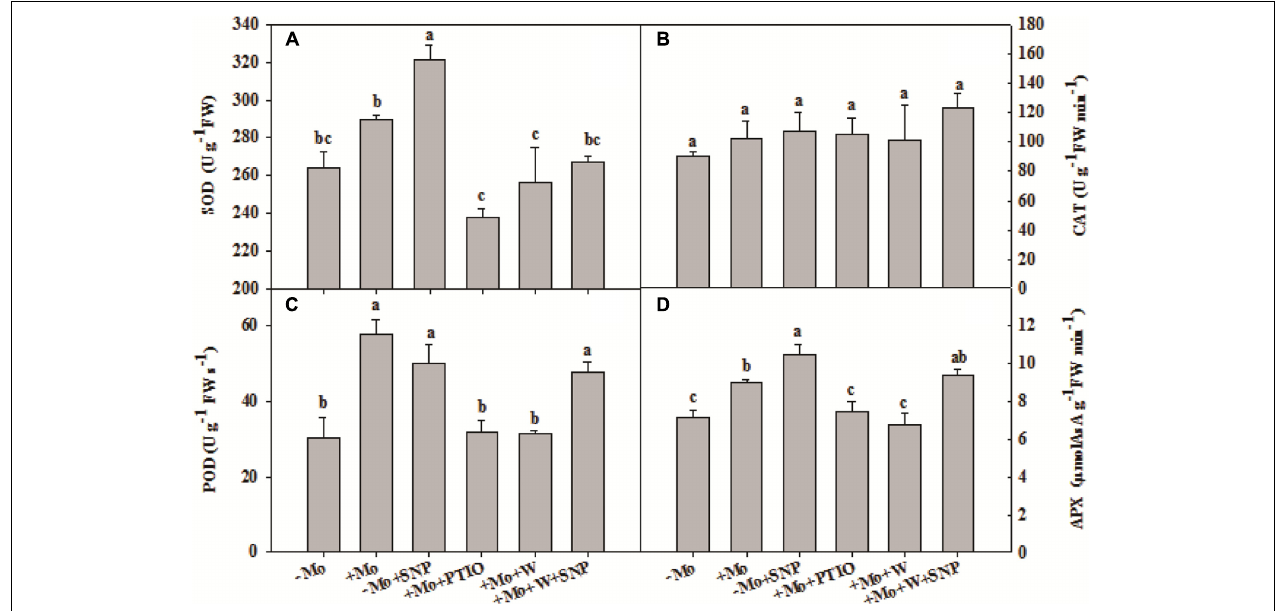
FIGURE 5 | Effects of molybdenum (Mo), 100 µ M tungsten (W, Mo-enzymes inhibitors), 200 µ M 2-phenyl-4,4,5,5-tetramethylimidazoline-3-oxide-1-oxyl (PTIO, NO scavenger), and 100 µ M sodium nitroprusside (SNP, NO donor) on activities of antioxidant enzymes in wheat leaves. The 30-day-old seedlings grown in –Mo and +Mo Hoagland solutions were detached and placed in distilled water for 2 h to eliminate potential wound stress and firstly pretreated with/without 200 µ M PTIO or 100 µ M W for 4 h, and then exposed to 10% polyethylene glycol 6000 (PEG) with/without 100 µ M SNP for 6 h. Seedlings cultivated with –Mo and +Mo solutions were regarded as the control. Different letters indicate significant differences between treatments by the Duncan-test ( p < 0.05, n =